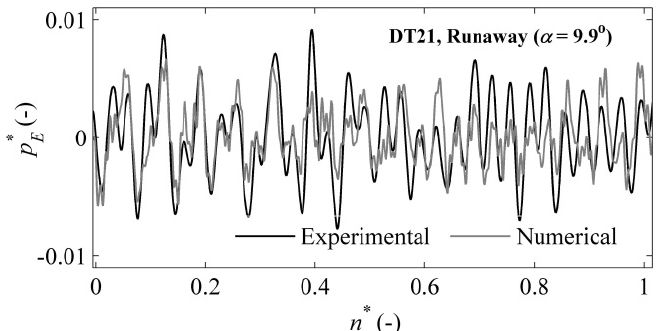
Figure 12. Instantaneous pressure fluctuations in the draft tube cone (DT21) over a complete rotation of the runner for the runaway operating point α = 9.9 ˝ ; fluctuations occur at a rotor stator interaction and blade passing frequency of 262.2 Hz.